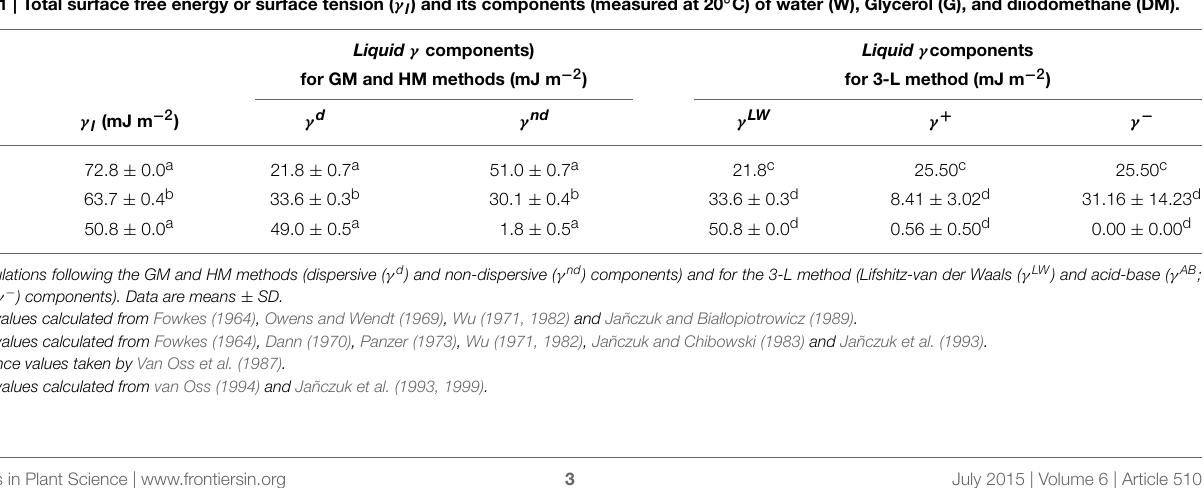
TABLE 1 | Total surface free energy or surface tension ( γ l ) and its components (measured at 20 ◦ C) of water (W), Glycerol (G), and diiodomethane